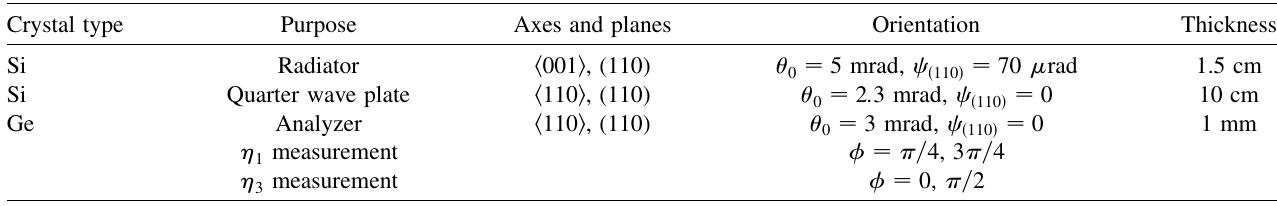
COHERENT BREMSSTRAHLUNG, COHERENT PAIR . . TABLE I. Description of the angle settings for the quarter wave plate setup, where (cid:3) and crystal axis, is the angle between the photon momentum and the indicated crystal plane, and (cid:9) is the azimuthal angle of the quarter wave plate relative to the radiator.